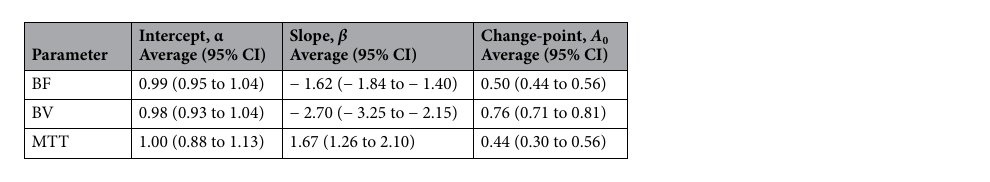
Table 1. Results of segmented regression derived using Eq.